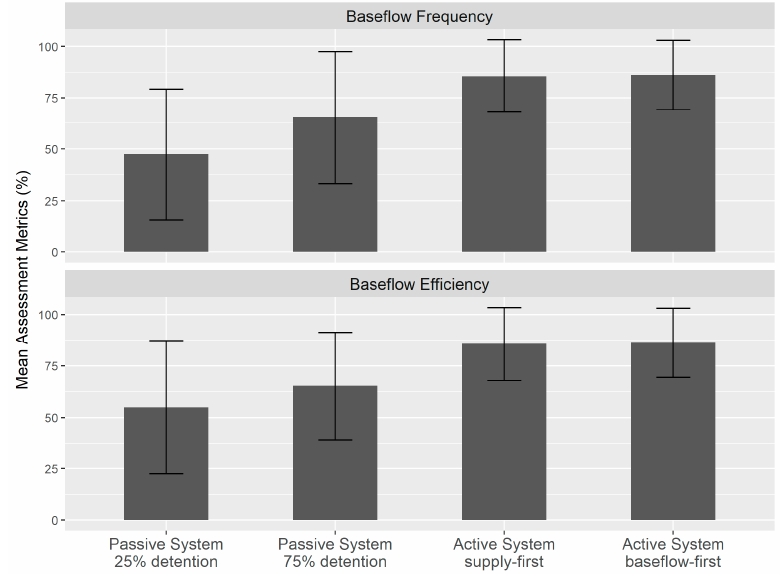
Figure 5. Mean value (bar) and associated standard deviation (error bar) for baseflow frequency and efficiency in the four system configurations that consider baseflow. Baseflow frequency and efficiency are expressed as percentages.